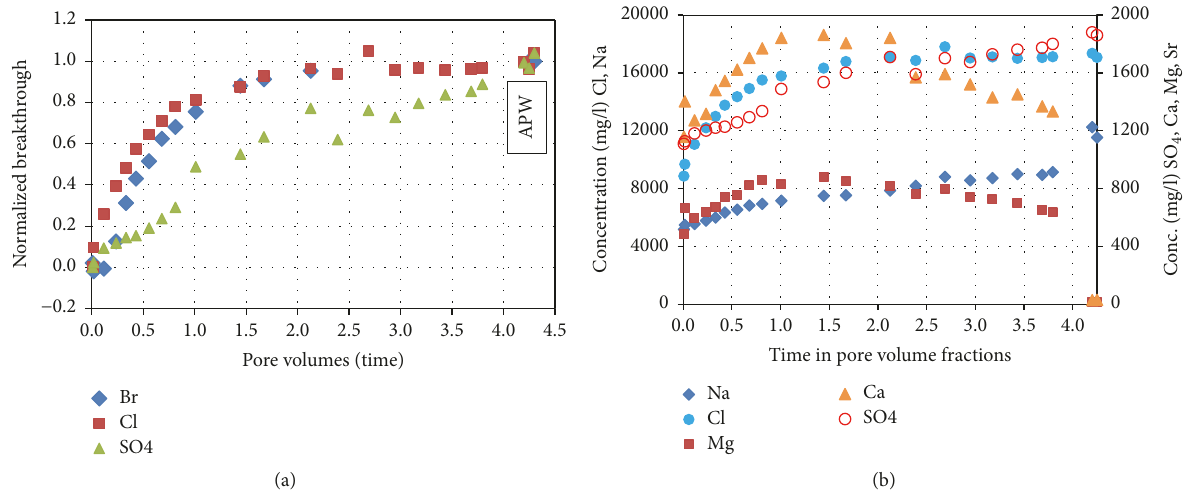
Figure5:(a)Breakthroughofbromide,chloride,andsulphateinanargillaceouslimestone,withexperimentaltimeconvertedtoporevolumes (water content); (b) elution of select cations for the same experiment. The composition of the injected artificial pore water (APW) is indicated on the right